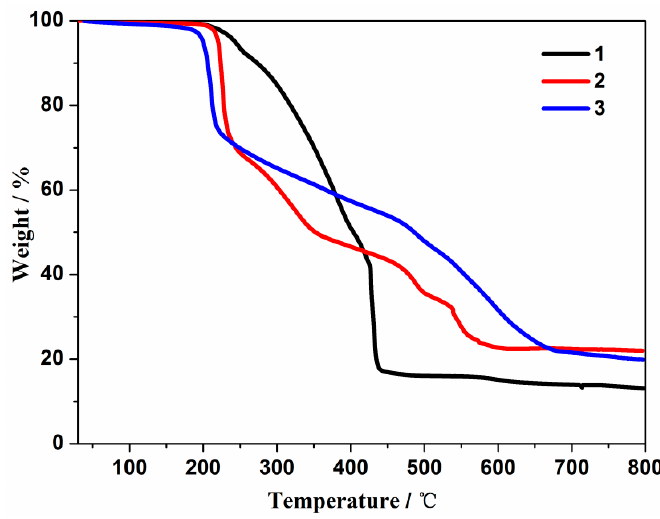
Figure 5. Curves of thermal gravimetric analysis (TGA) for compounds 1 – 3 .